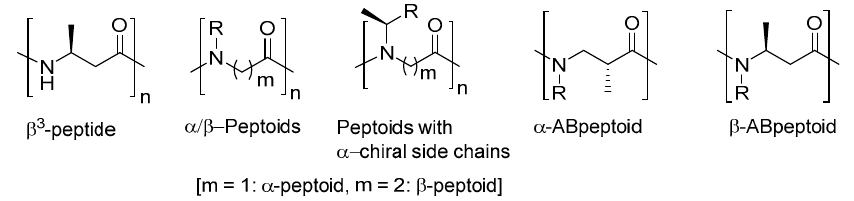
Figure 1. General structures of β 3 -peptides, α - and β -peptoids, α - and β -peptoids with α -chiral side chains, α -ABpeptoids and β -ABpeptoids.